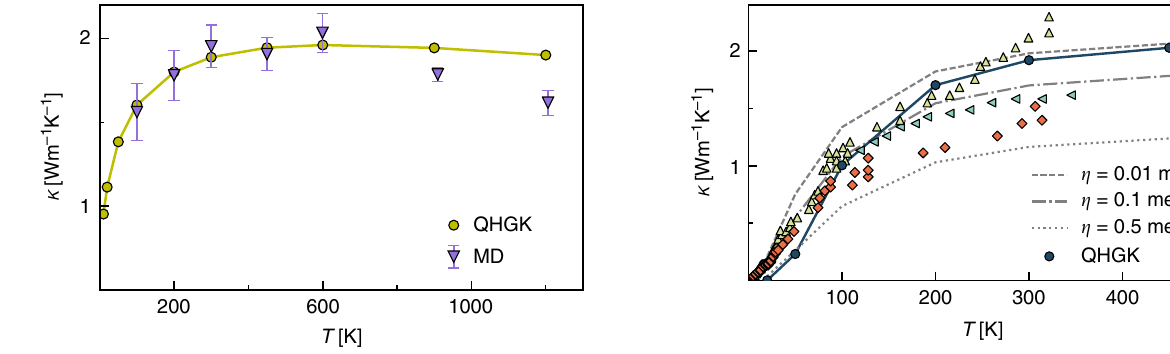
Fig. 1 Classical thermal conductivity. Comparison between the thermal conductivity of a-Si computed for a 1728-atom supercell by the classical Green – Kubo theory of linear response using either our QHGK approach (Eq. (3), green) or equilibrium molecular dynamics (purple). The vertical bars indicate statistical errors obtained by means of cepstral analysis, as explained in Ref. 22 . The k xx , k yy and k zz components of thermal conductivity tensor κ are averaged to obtain a value corresponding to an isotropic amorphous media